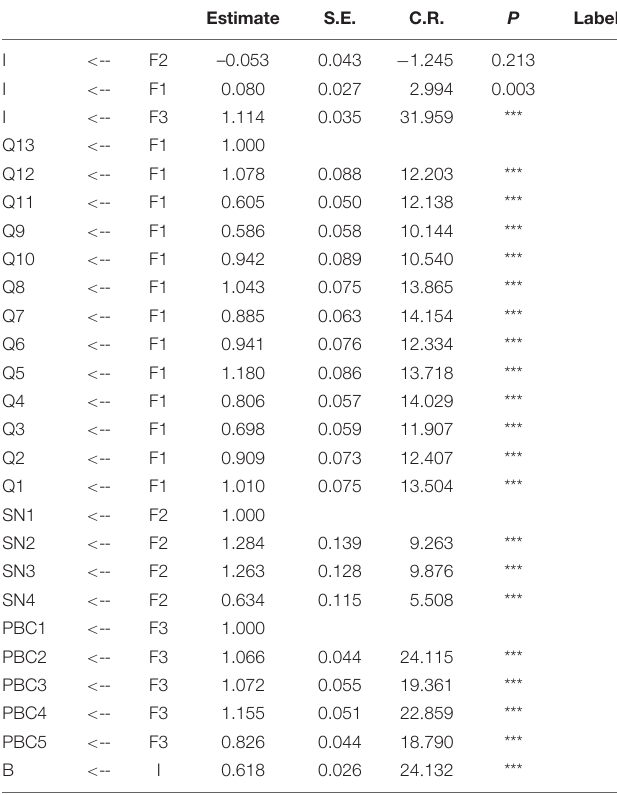
TABLE 2 | Parameter estimates for means structure model.